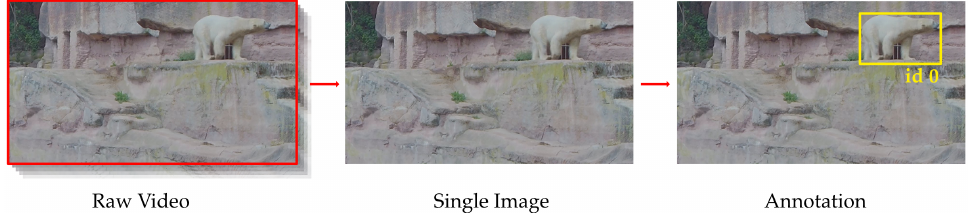
Figure 2. First, single frames are captured from the videos recorded in the zoos. Next, two biologists create bounding boxes for the animals and label their identities. They do not know the other person’s decision during the labeling process. The agreement between the two experts is checked across the whole dataset. Those instances in which they disagreed regarding the identity of the shown animals were collaboratively discussed. Only ten instances remained unclear. We excluded those from the dataset to ensure the highest quality of